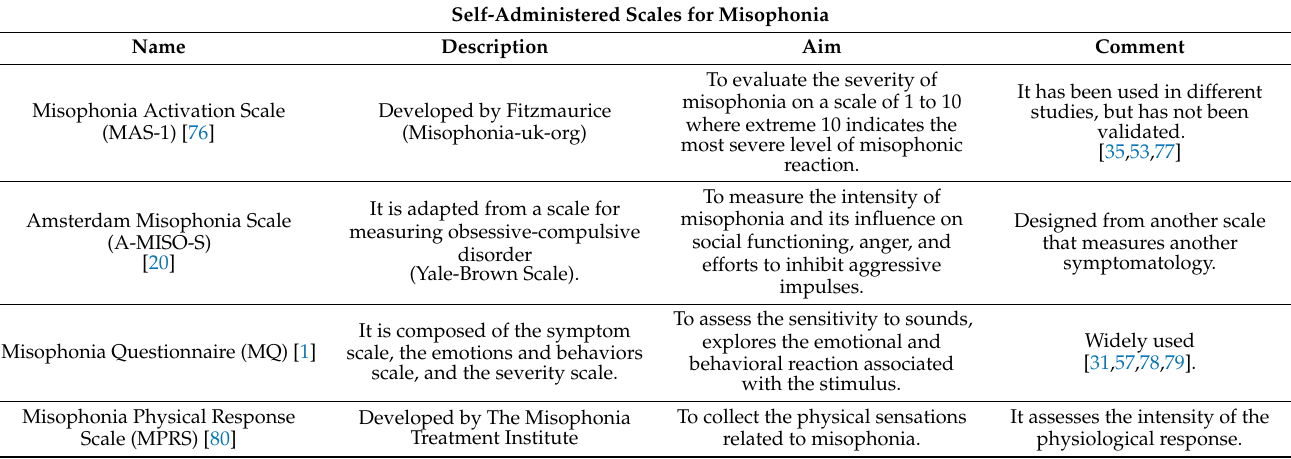
Table 2. Self-administered scales for